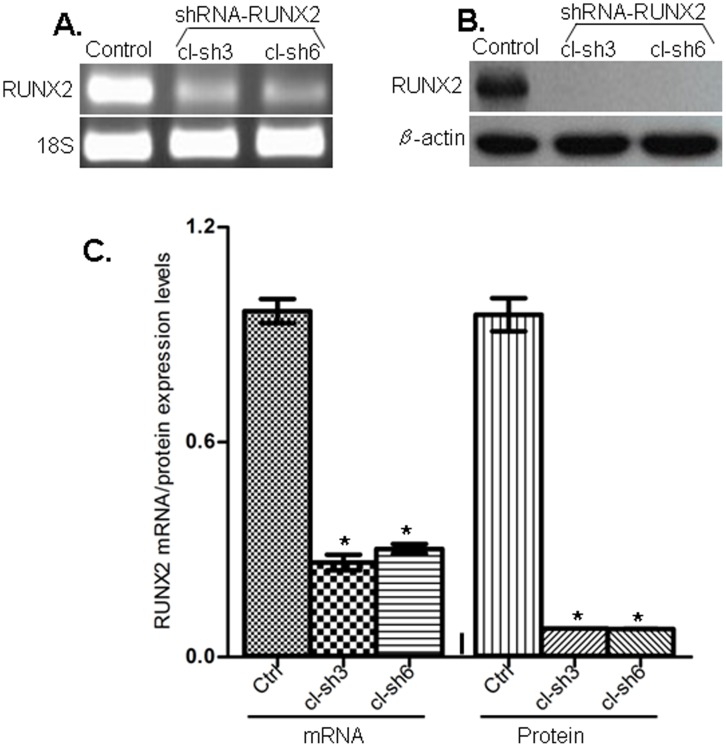
Analysis of RUNX2 expression in SKOV3 cells.A. Semi-quantitative duplex RT-PCR analysis of RUNX2 mRNA expression levels in the shRNA-RUNX2 clones 3 and 6, compared to the mock-transfected control clone. Displayed are images of representative results following sqRT-PCR analysis. The 18S ribosomal RNA gene was used as internal standard. B. Western-blot analysis of RUNX2 protein expression in the shRNA-RUNX2 clones cl-sh3 and cl-sh6, compared to the mock-transfected clone (ctrl). β-actin was used as a loading control. C. Densitometric analysis of RUNX2 mRNA/protein expression levels in the clones sh3 and sh6, compared to the control. Differences between the control clone and shRNA-RUNX2 clones were determined by a Student's t-test. Error bars denote ± SEM; *indicates statistical significance (P<0.05).